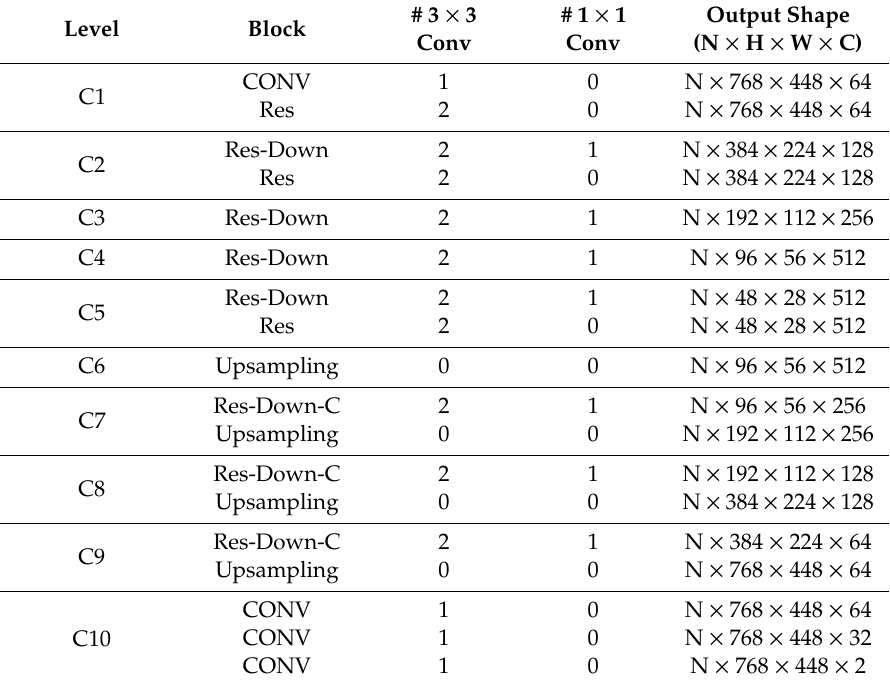
Table 1. The architecture of a 31-layer